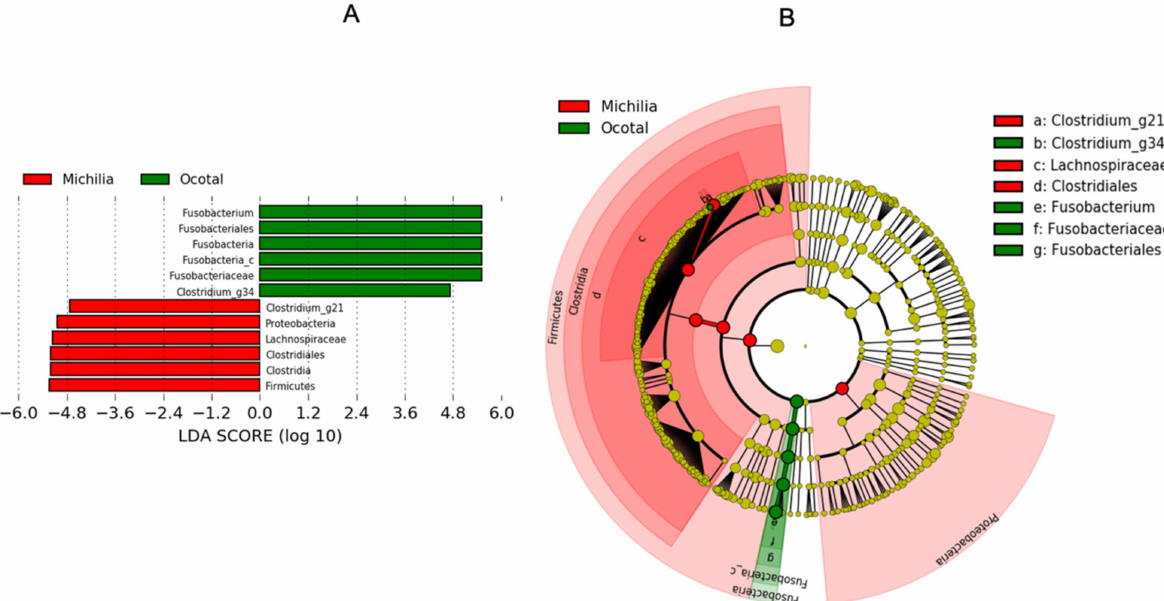
Figure 6. LEfSe analysis of fecal bacterial microbiota from two populations of Mexican wolves ( Canis lupus baileyi ) in Michilia and Ocotal, Mexico. ( A ) Bar graph shows LDA scores which indicate the taxonomic key for differentiation between populations. ( B ) The cladogram generated by LEfSe indicates the main biomarkers between populations. Each successive circle represents one phylogenetic level. Red-colored regions indicate taxa enriched in Michilia Mexican wolves, while green-colored regions indicate taxa enriched in Ocotal Mexican